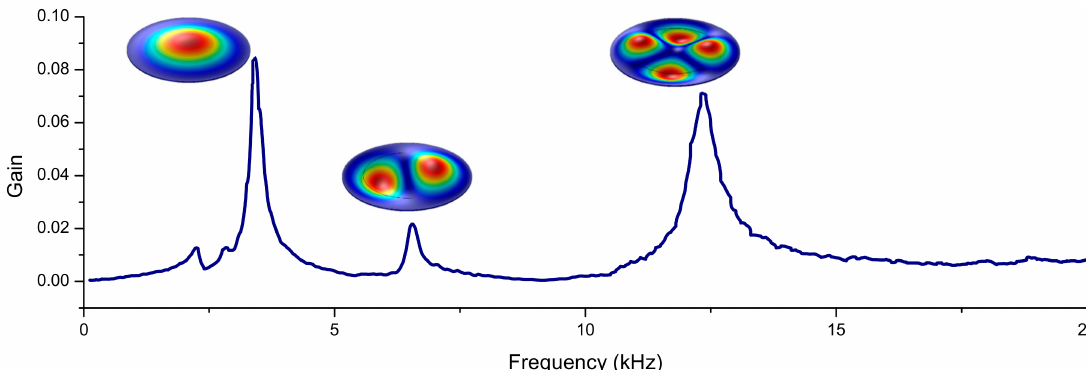
Figure 5. Frequency sweep from 0 to 20 kHz on a 12 mm membrane at 6 V RMS . Three main resonance modes are observed, respectively, at 3.45 kHz, 6.57 kHz, and 12.3 kHz. Mode shape is illustrated on each peak.